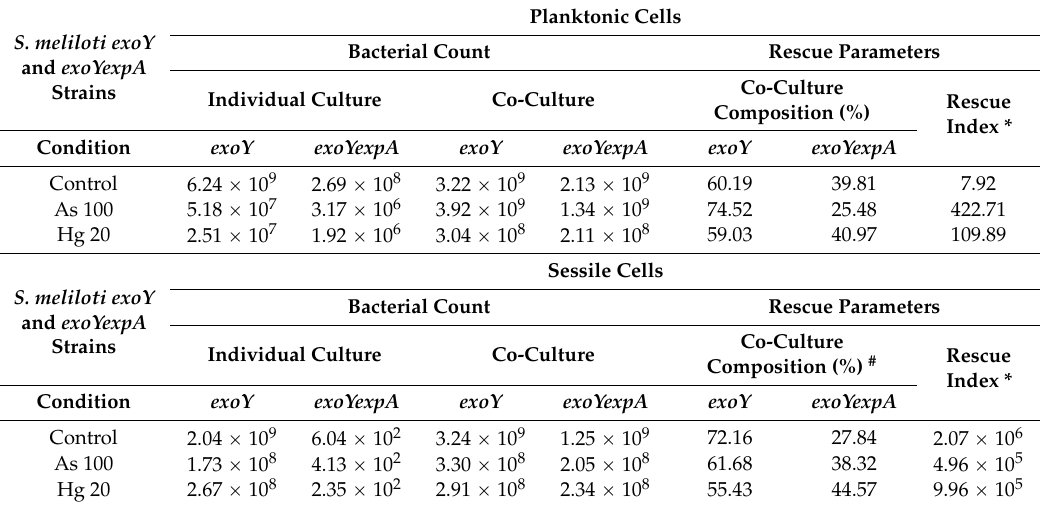
Table 4. Planktonic and sessile cell count of individual and co-culture of S. meliloti exoY and exoYexpA